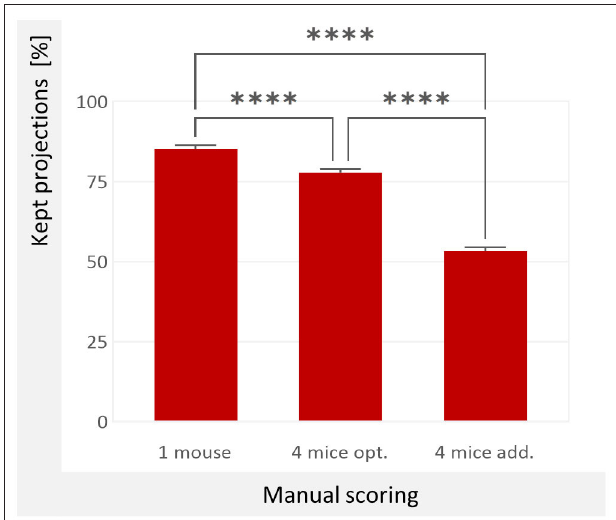
FIGURE 5 | Used projections according to manual motion detection. We averaged the manual examination of all twelve mice. 1 mouse: 85.22 %; Only the MOI is considered, which emulates a single-mouse scan. 4 mice opt: 77.78 %; all mice but only their relevant motion is considered, which simulates a 4-mice-scan with overlap-based projection rejection. 4 mice add.: 53.38 %; each motion is added up without considering the actual overlap, which simulates a 4-mice scan with breathing pads and conservative projection selection. The values differ significantly (p < 0.0001 as indicated by ****, one-way